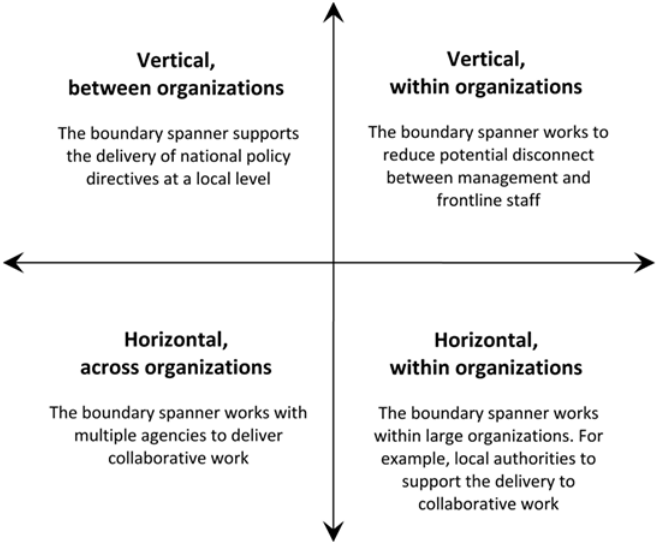
Figure 2 Examples of boundary spanning activities (source: Sinclair 2017, p.